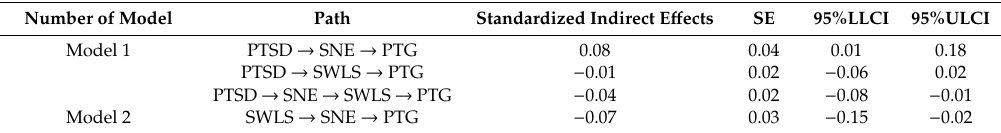
Table 6. Significance test of mediation e ff ects by